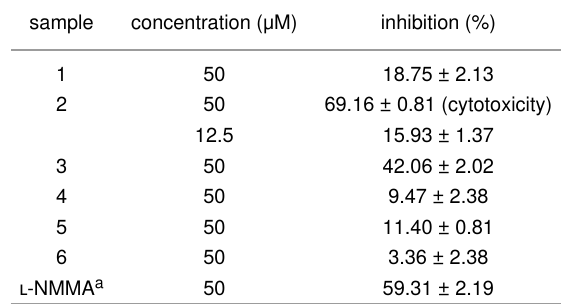
Table 2: Inhibitory effects of compounds 1 – 6 on LPS-stimulated NO